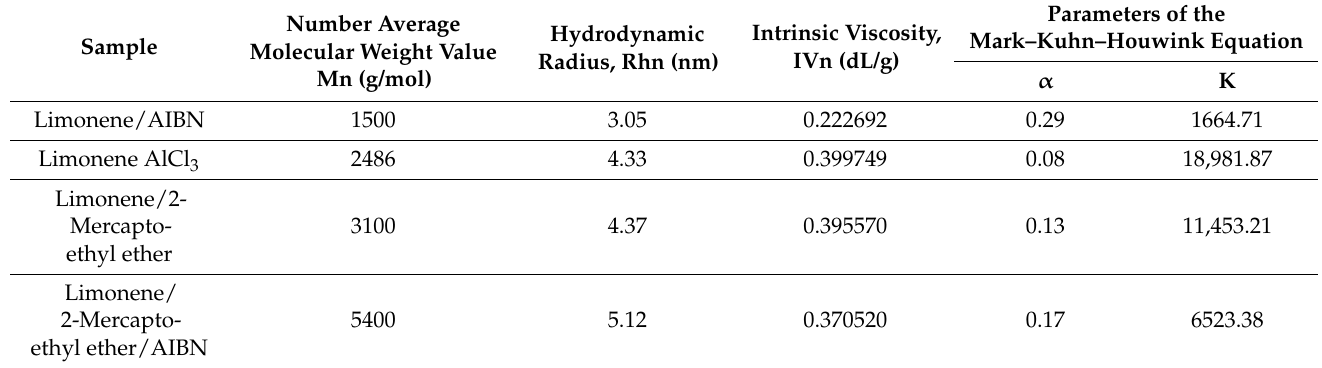
Table 1. The value of the molecular-weight characteristics of the samples depending on the synthesis.